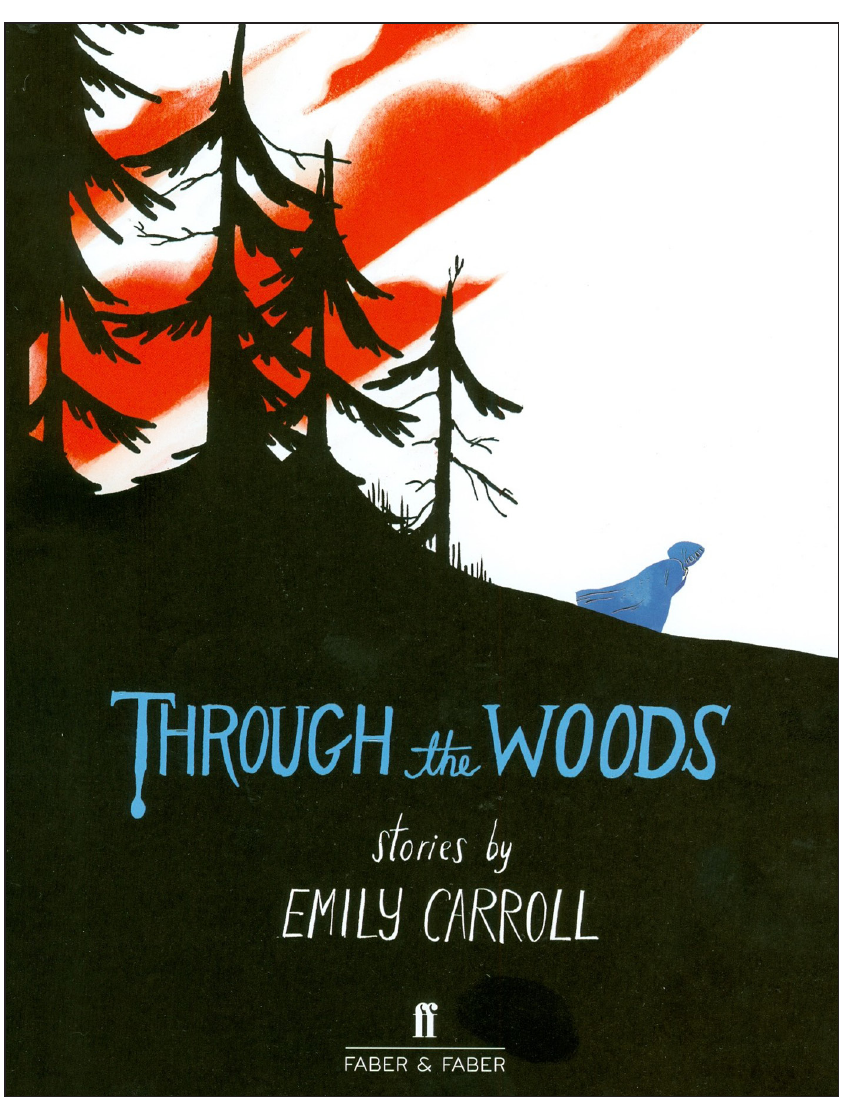
Figure 4: Carroll, E (2014). Through the Woods (New York: Faber & Faber, n.pag.) © Emily